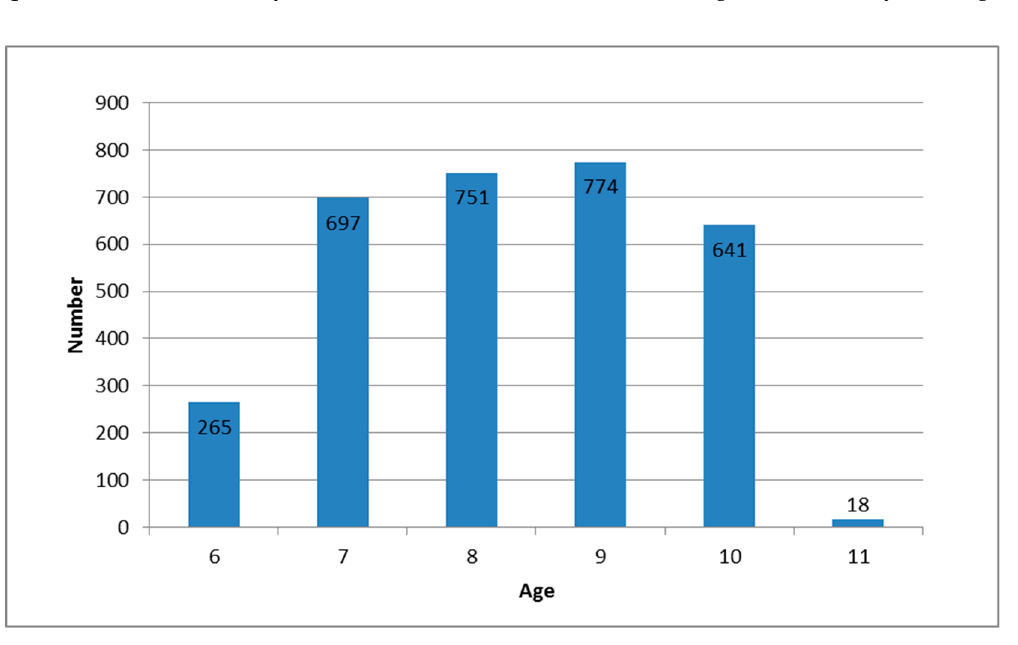
Figure 1. A ge distribution of the investigated children. Figure 1. Age distribution of the investigated